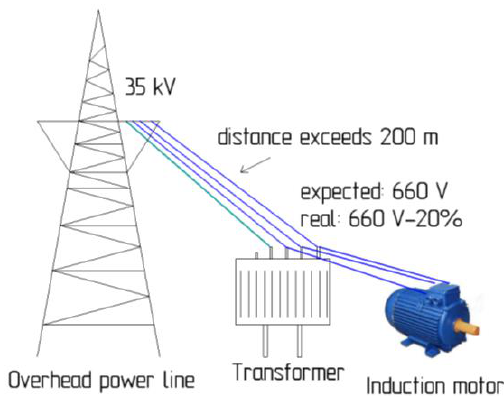
Figure 1. Voltage drop in overhead power line.